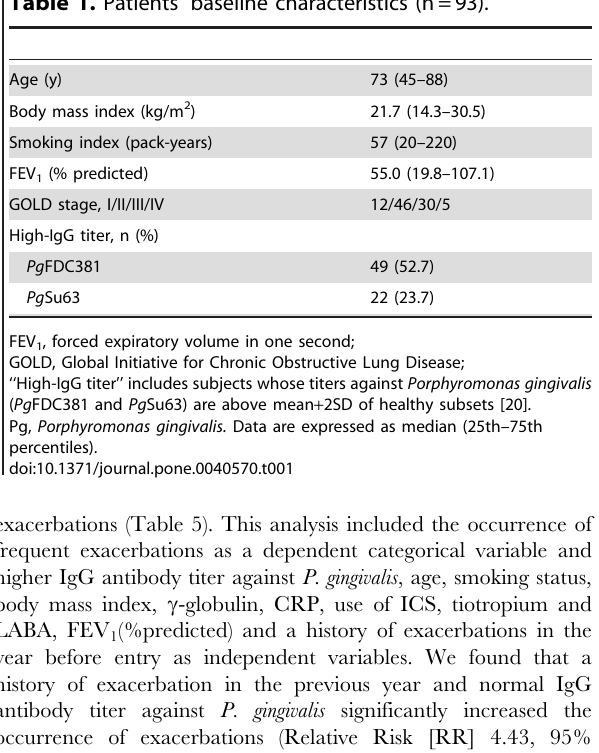
Table 1. Patients’ baseline characteristics (n =93).